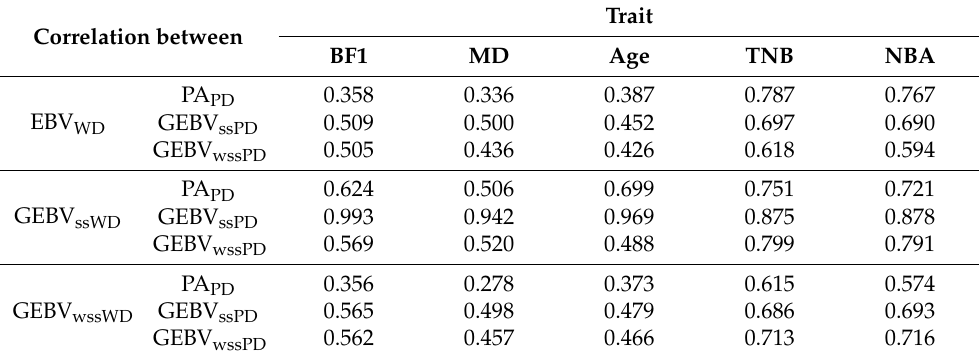
Table 5. Correlation of the weighted final genomic estimates (GEBVwssWD) of the validated group (200 animals) with their parent’s average predictions (PA), genomic predictions based on pedigree and genome data using the ssGBLUP (GEBV ssPD ) and wssGBLUP (GEBV wssPD ) methods (Scenario 5) *. Trait Correlation between BF1 MD Age TNB NBA PA PD 0.358 0.336 0.387 0.787 0.767 EBV WD GEBV ssPD 0.509 0.500 0.452 0.697 0.690 GEBV wssPD 0.505 0.436 0.426 0.618 0.594 PA PD 0.624 0.506 0.699 0.751 0.721 GEBV ssWD GEBV ssPD 0.993 0.942 0.969 0.875 0.878 GEBV wssPD 0.569 0.520 0.488 0.799 0.791 PA PD 0.356 0.278 0.373 0.615 0.574 GEBV wssWD GEBV ssPD 0.565 0.498 0.479 0.686 0.693 GEBV wssPD 0.562 0.457 0.466 0.713